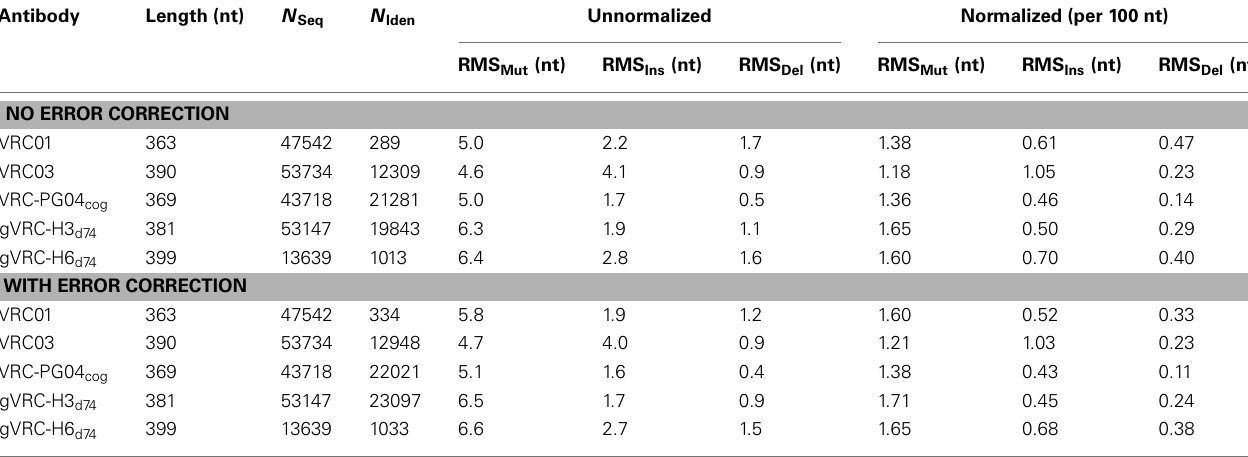
Table 2 | Statistical analysis of 454 pyrosequencing-induced errors for five plasmid antibodies.